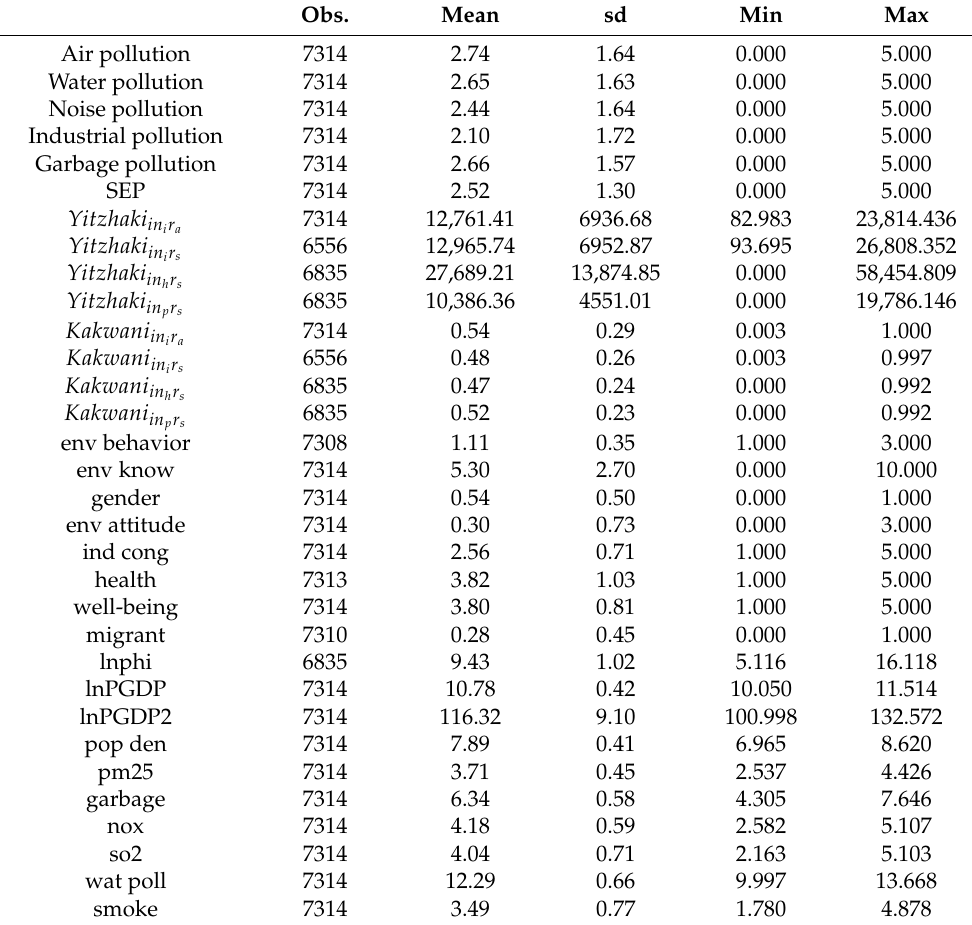
Table 1. Descriptive statistics of